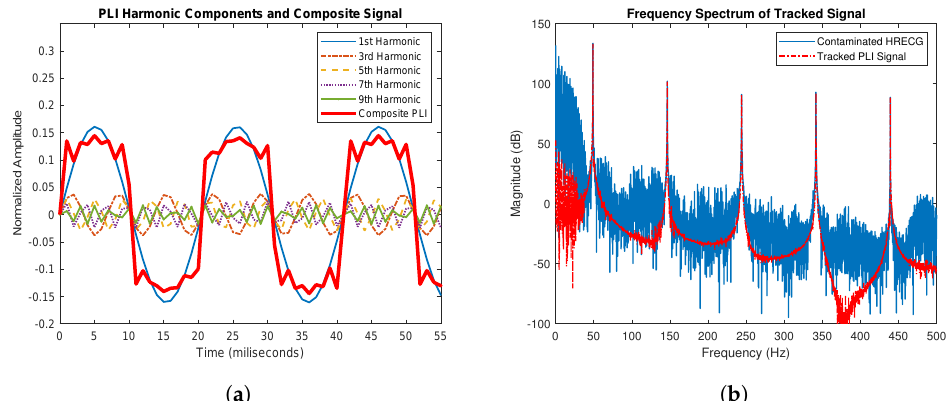
Figure 6. The amplitude scale of PLI harmonics and their tracking. ( a ) The amplitude scale of odd harmonics in the composite PLI signal; ( b ) the frequency spectrum of the tracked PLI signal.